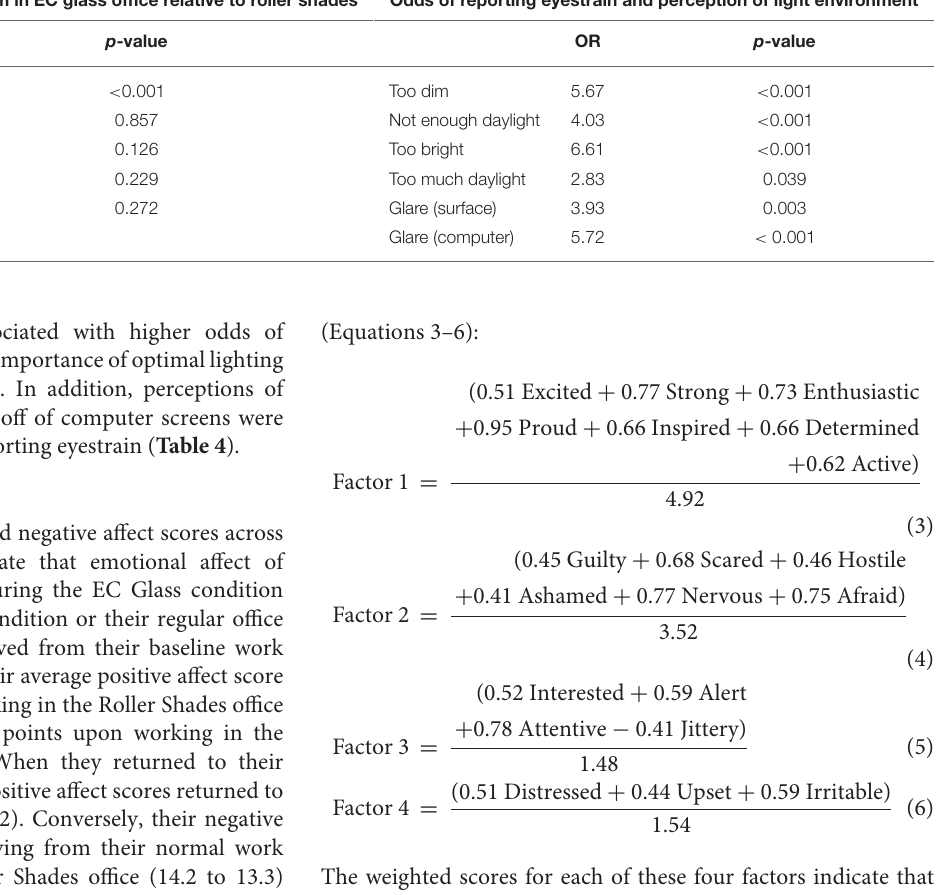
TABLE 4 | Linear mixed effects model results for the (a) associations between self-reported physical health symptoms and office condition; and (b) associations between self-reported eyestrain and perceptions of lighting environment. Symptom (a) (b) Odds of reporting symptom in EC glass office relative to roller shades Odds of reporting eyestrain and perception of light